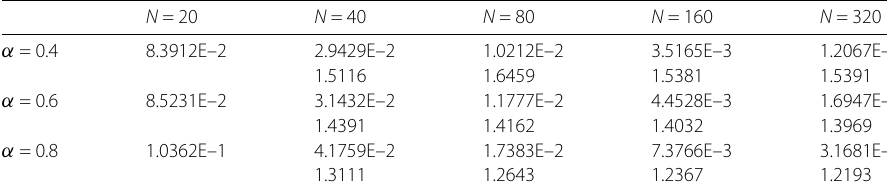
Table 2 E M , N errors and orders of convergence for L1 FEM with r = (2 – α )/ α 2 N = 20 N = 40 N = 80 N = 160 N = 320 α = 0.4